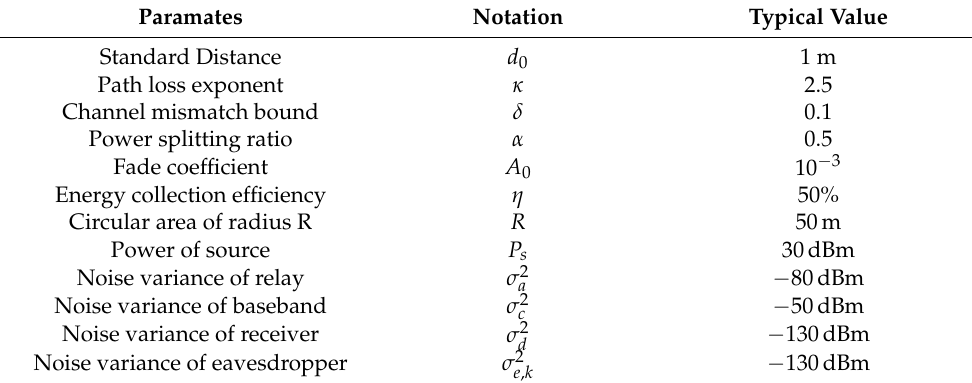
Table 1. Simulation parameter